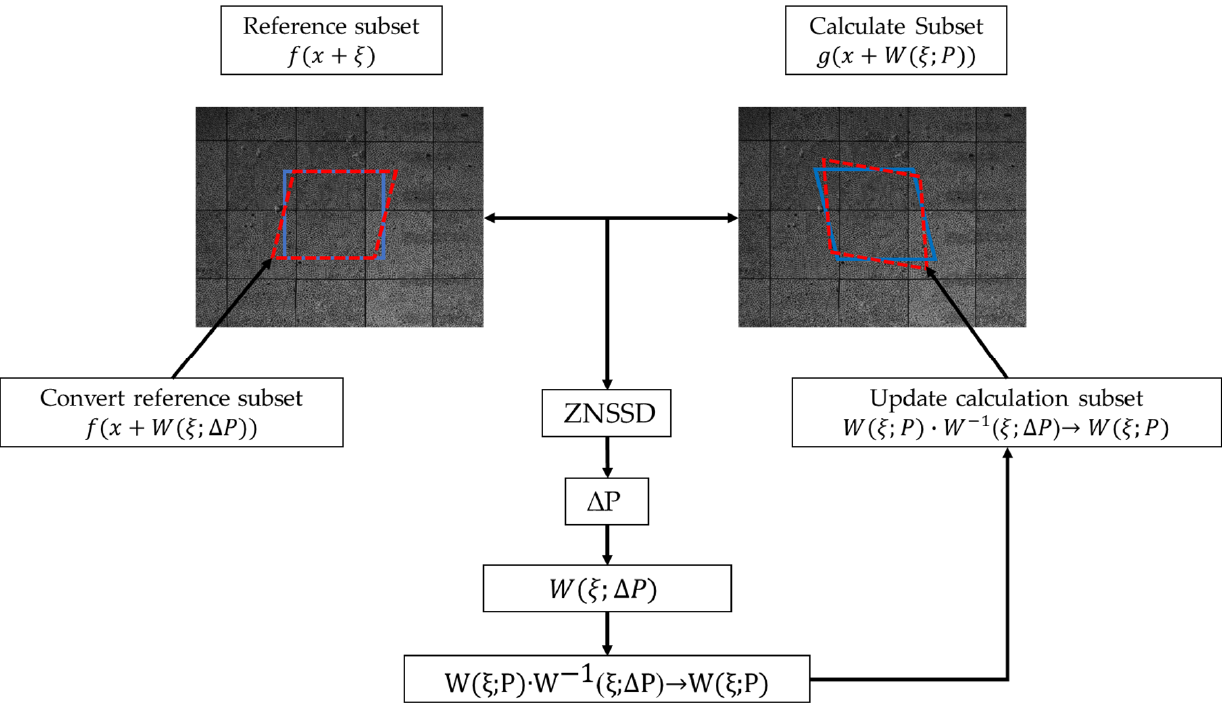
Figure 4. Schematic diagram of DIC test principle.